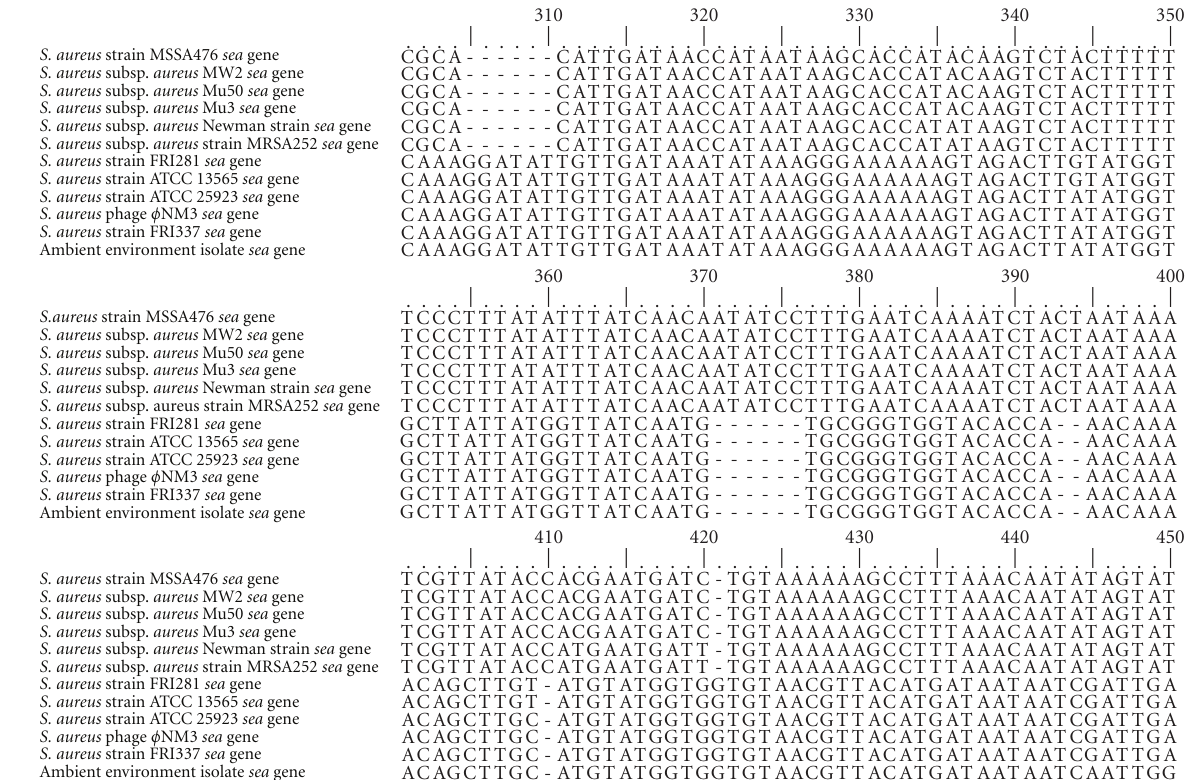
Figure 2: ClustalX2 alignment of top BLASTN hits of the sea gene from the ambient environmental isolate. The sea PCR product amplified from the cultured ambient air isolate was verified against the GenBank nonredundant database. The FASTA files of the top hits were downloaded and aligned using ClustalX2. The Accession number for the sea -related gene is HQ698309.